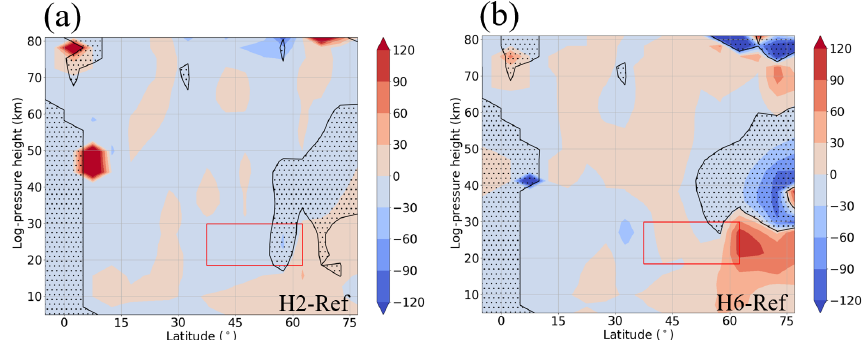
Figure 8. Zonal-mean refractive index of SPW 1 differences between the H2 (a) and H6 (b) simulations and the Ref simulations. The hashed regions denote regions of negative refractive index of the H2 and H6 simulations. The positions of the GW hotspots are illustrated by the red boxes.